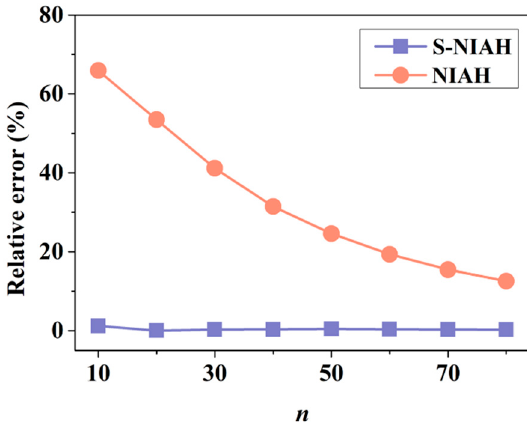
Figure 12. Relative error with respect to n under different methods.